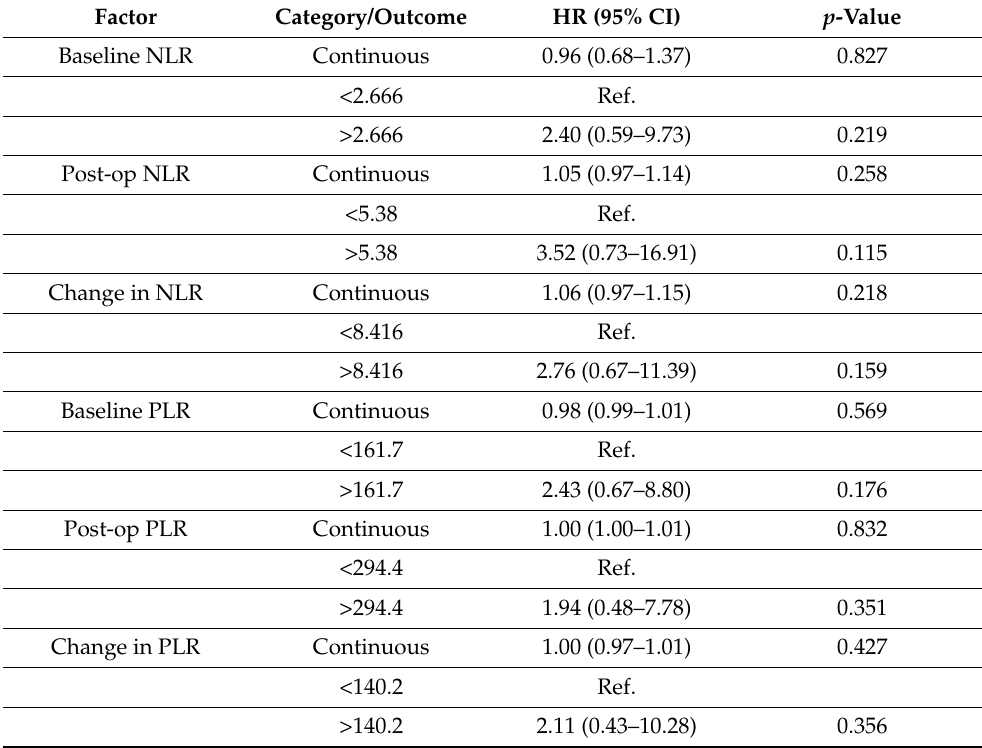
Table 6. Multivariable analysis of NLR and PLR for local-recurrence free survival.